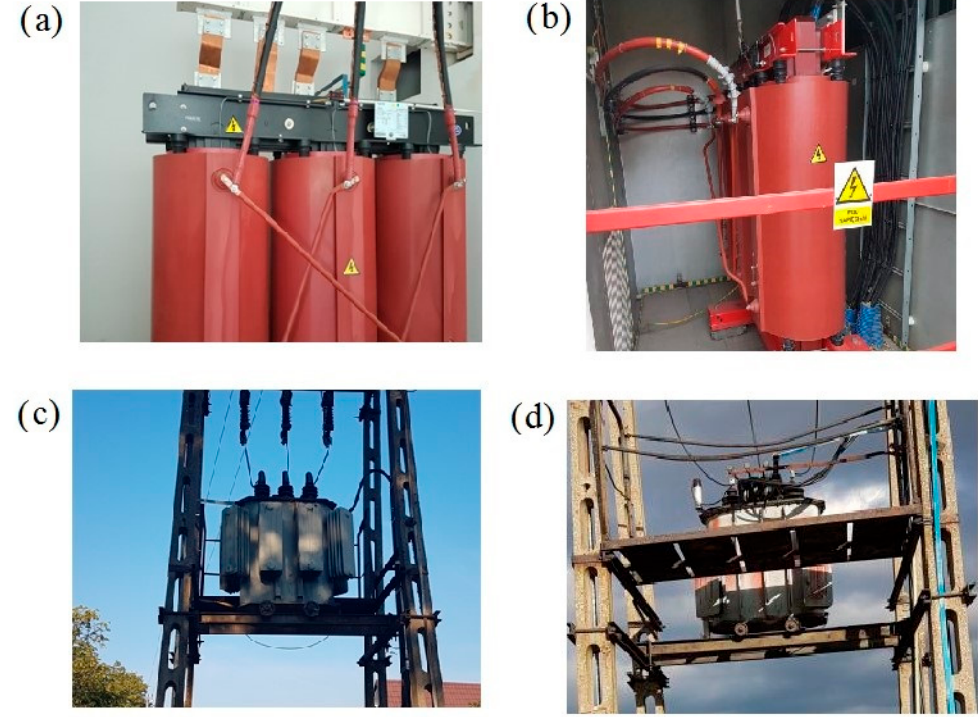
Figure 4. Photos of the tested power transformers: ( a ) first, ( b ) second, ( c ) third, and ( d ) fourth.